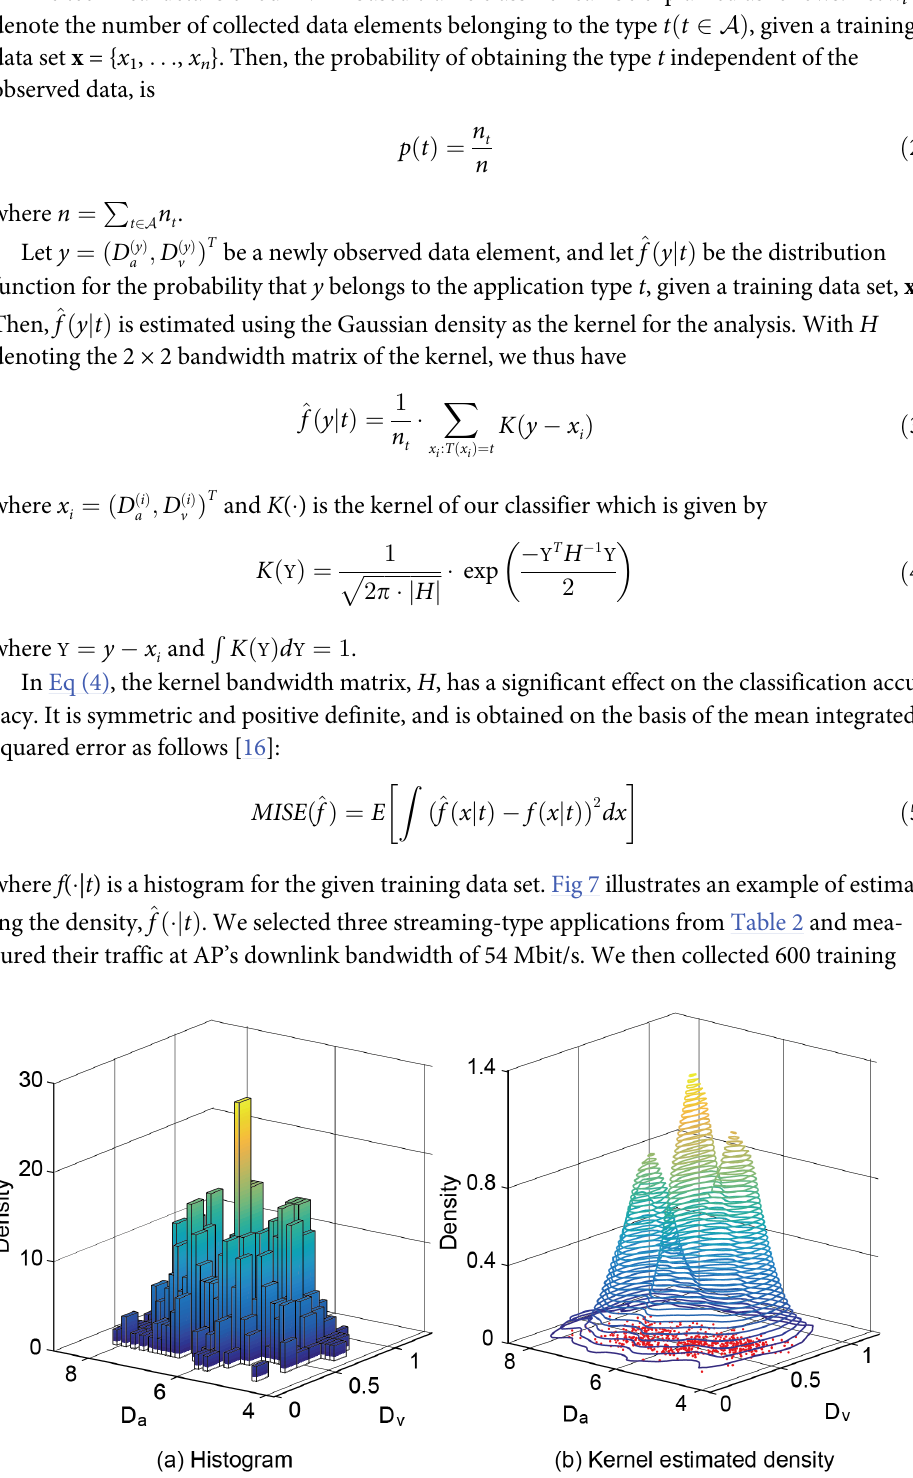
Fig 7. Examples of (a) the histogram and (b) the kernel estimated density. Given 600 training instances for the average and the normalized standard deviation of the streaming-type application traffic, i.e., D a and D v , respectively.